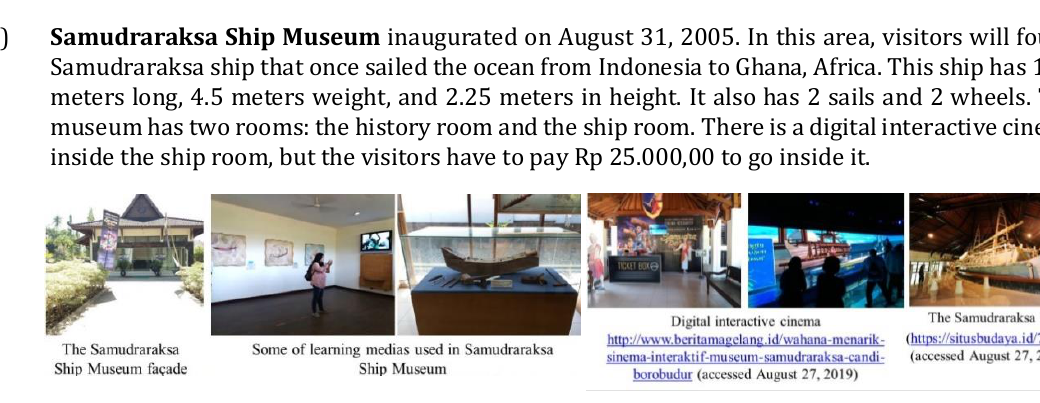
Fig. 9 Samudraksa Ship